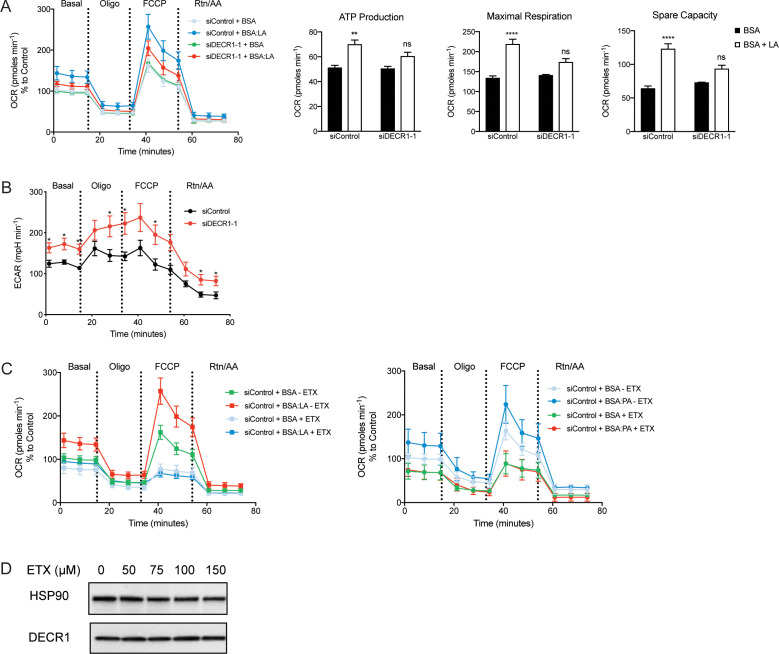
Effects of DECR1 on prostate cancer cellular metabolism.(A) Oxygen consumption rate (OCR) was assessed in LNCaP cells supplemented with the PUFA linoleic acid (LA). Each data point represents an OCR measurement. ATP production, maximal mitochondrial respiration and mitochondrial spare capacity were assessed. (B) Extracellular acidification rate (ECAR) was assessed in LNCaP cells. Each data point represents an ECAR measurement. (C) OCR of LNCaP cells supplemented with PUFA LA (top) or palmitic acid (PA, bottom) treated with etomoxir (ETX, 100 µM). Each data point represents an OCR measurement. (D) DECR1 protein expression after 48 hr treatment with varying concentrations of etomoxir. Statistical analysis was performed using two-tailed Student’s t-test: *p<0.05, **p<0.01 and ****p<0.0001.